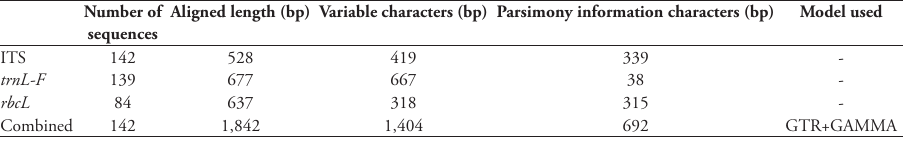
Table 3. Statistics for the molecular datasets used in this study.